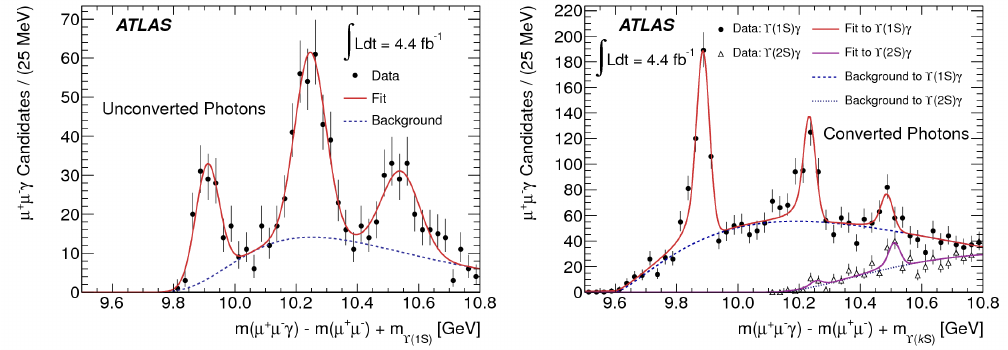
Figure 8: The mass distribution of χ b → Υ (1 S ) γ candidates for unconverted photons (left) and the mass distributions of χ b → Υ ( kS ) γ (k = 1, 2) candidates formed using converted photons